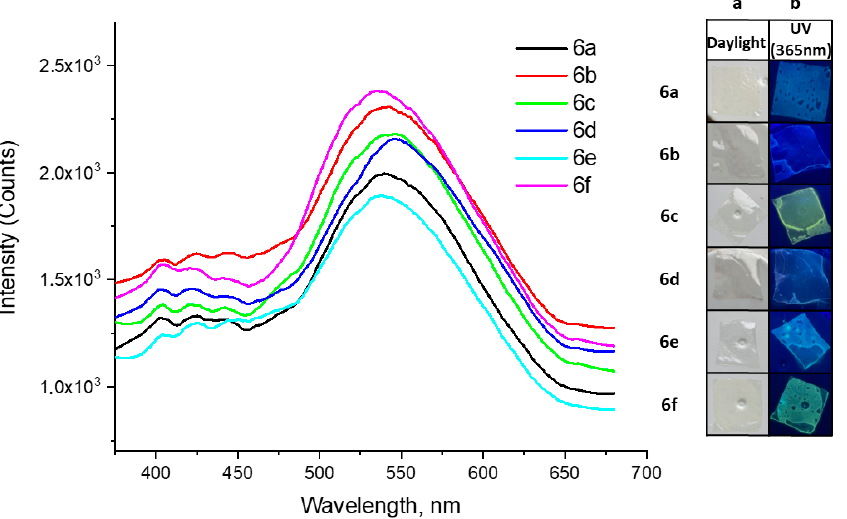
Figure 4. Emission spectra of dyes 6a–f in PVA films ( a ) and photographs of the samples under daylight and 365 nm UV irradiation ( b ). daylight and 365 nm UV irradiation ( b